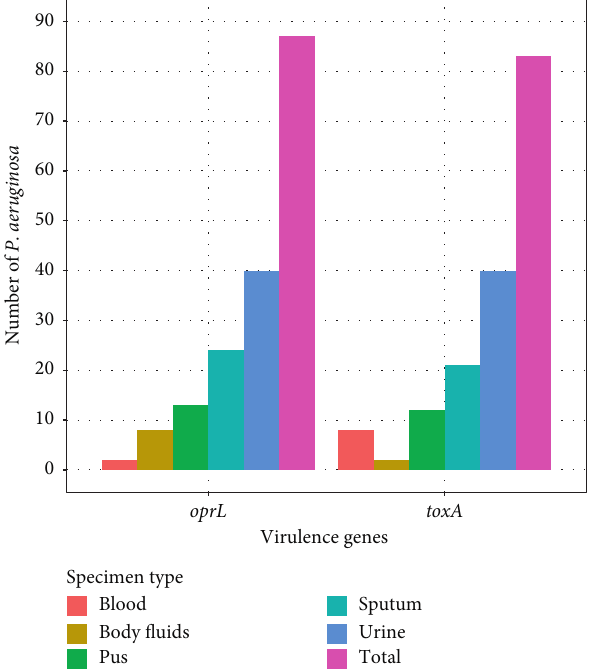
Figure 2: Prevalence of virulence genes ( oprL and toxA ) in P. aeruginosa